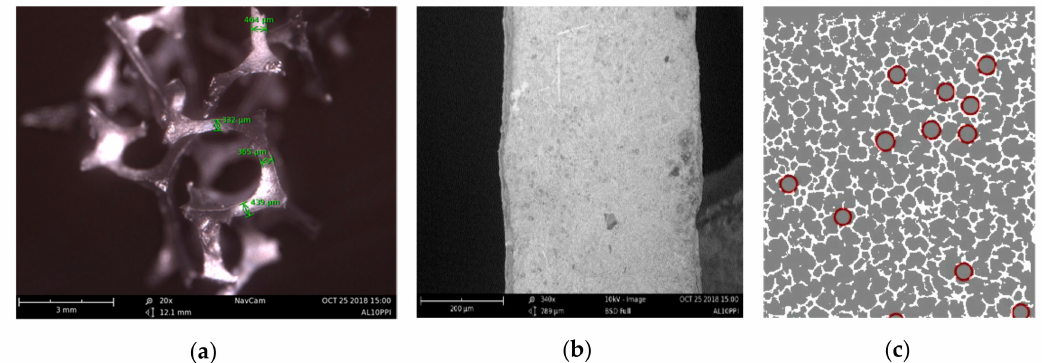
Figure A1. ( a ) SEM image of the aluminum foam; ( b ) zoomed view of a fiber; ( c ) automatic individuation of pores having similar